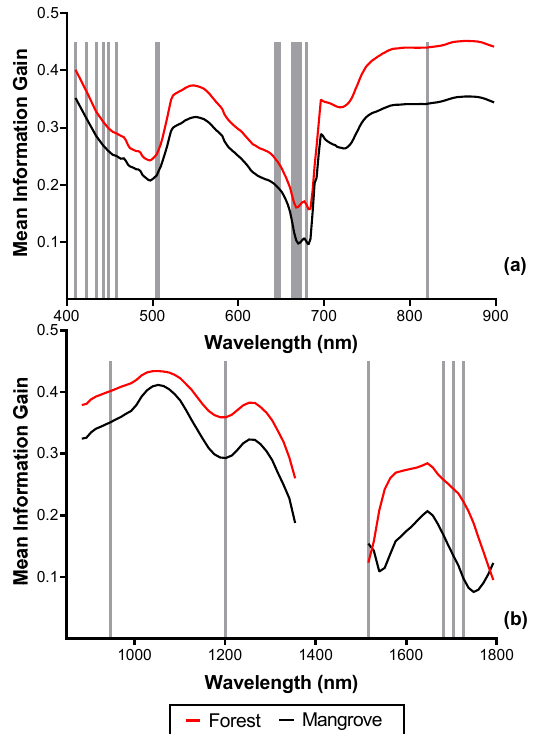
Figure 9. SCM of mangrove and terrestrial forest with vertical lines showing the positions of the optimal bands selected by the forward feature selection (FFS). ( a ) Eighteen bands selected from the MIG–VNIR (250 m), ( b ) 6 bands selected from the MIG–SWIR (250 m) data. Because separability was higher for MIG, positions of optimal ME bands not shown.